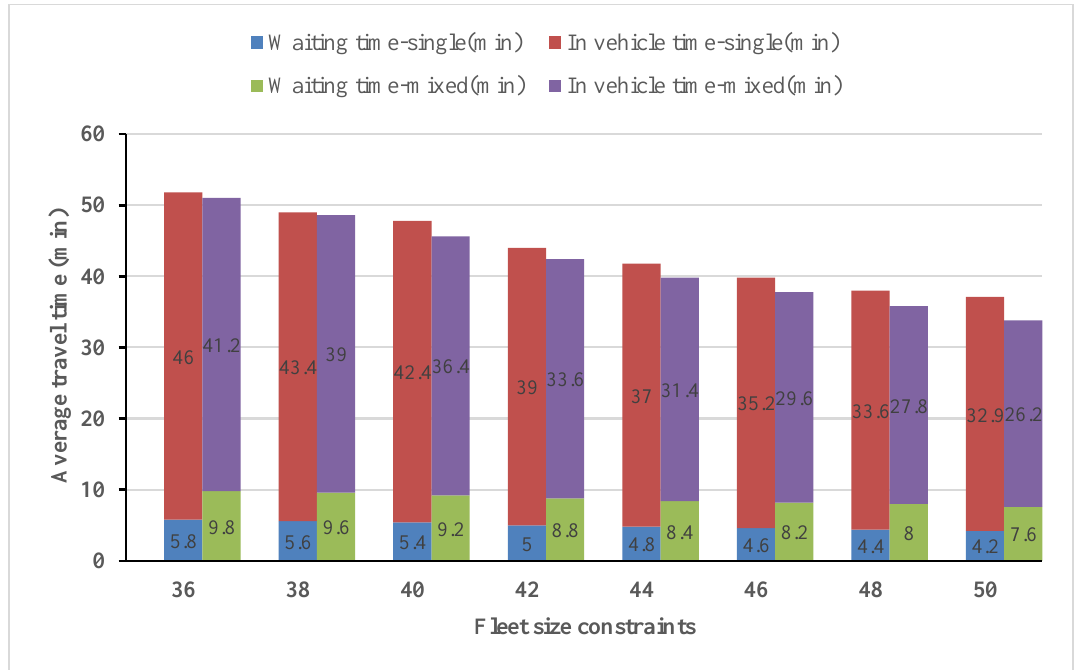
Figure 6. Average travel time of different scheduling types.